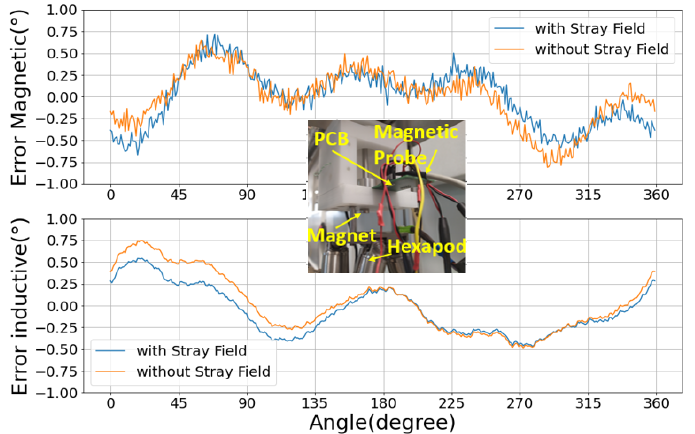
Figure 8. Angle response curves with and without a magnetic stray field generated by a nearby parasitic magnet. The inset is a picture of the experimental configuration. The stray field impact is modest for both sensors.